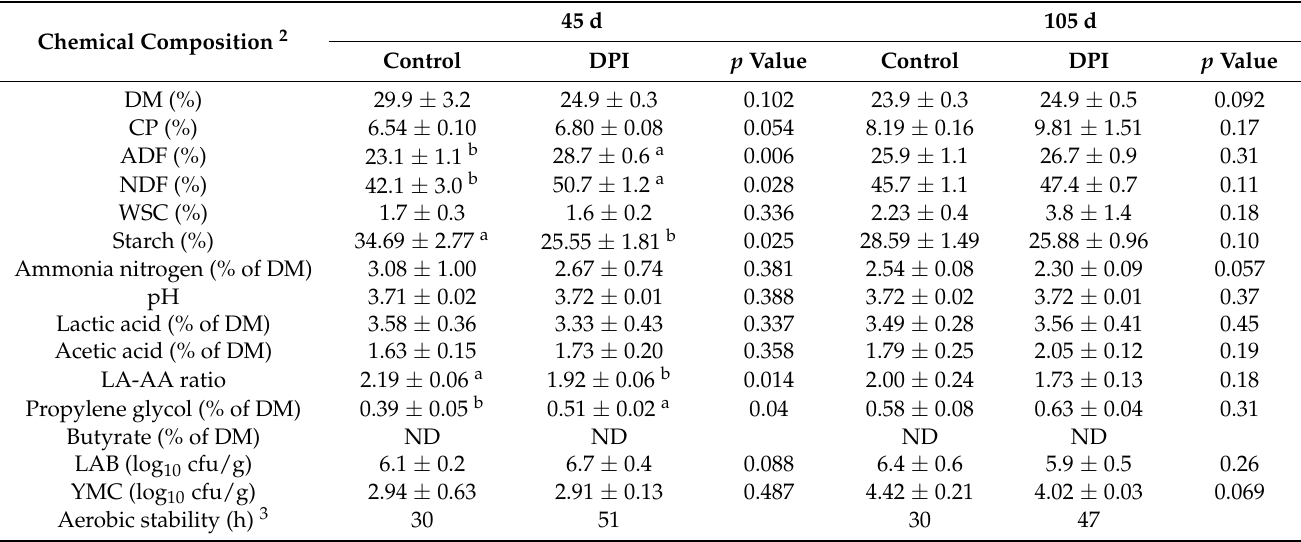
Table 1. Effects of inoculant application 1 on the quality and chemical composition of laboratory minisilos at different ensiling